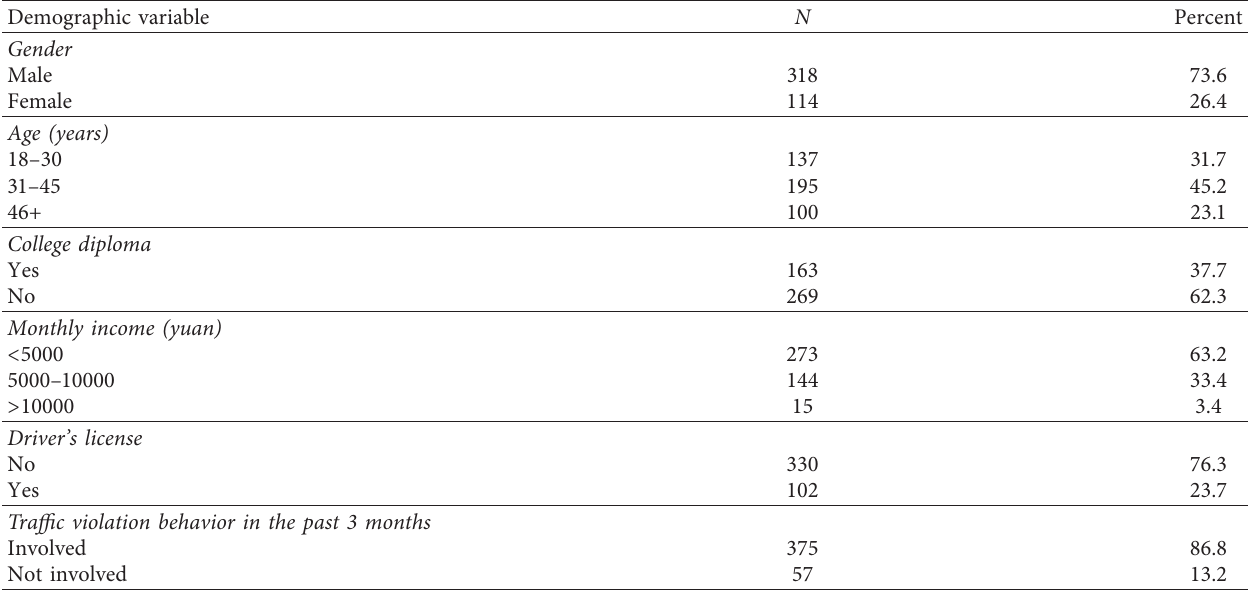
Table 2: Demographic profile of